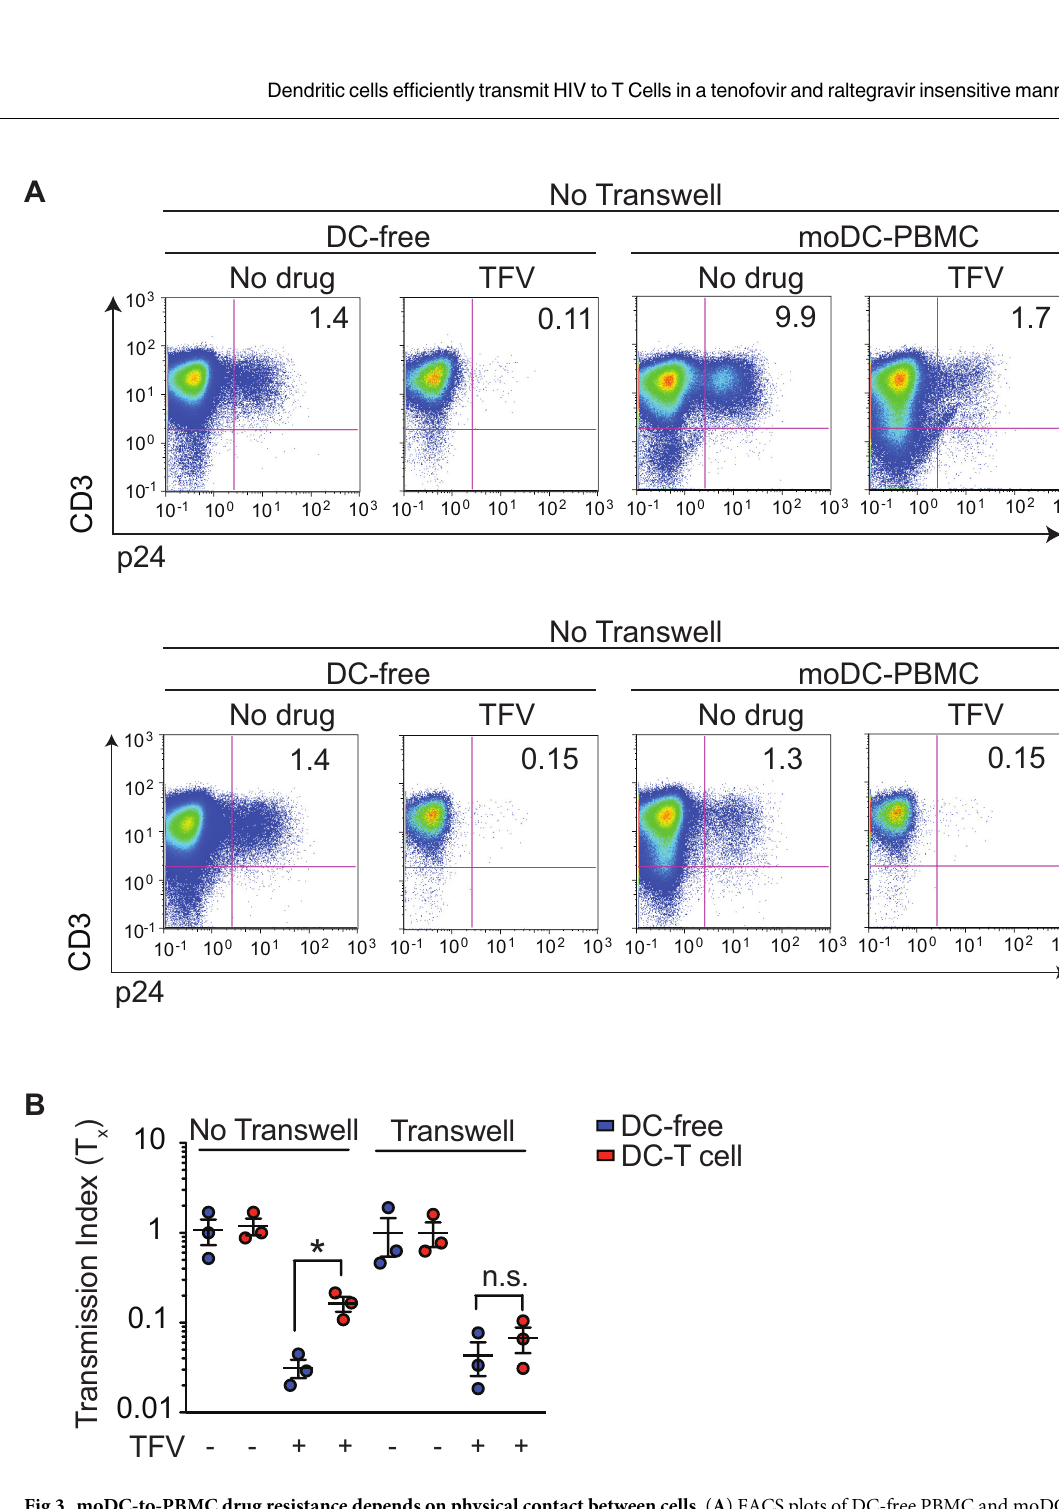
Fig 3. moDC-to-PBMC drug resistance depends on physical contact between cells. ( A ) FACS plots of DC-free PBMC and moDC- to-PBMC infection with ( bottom ) or without ( top ) a transwell system, in which DCs are physically separated from PBMCs by a transwell membrane. Infection occurs in the absence of presence of 10 μM of TFV. ( B ) Drug insensitivity (T x ) of DC-free or moDC- to-PBMC infection with or without 10 μM of TFV and in the absence of presence of a transwell system. Mean ± s.e.m ( η = 3 donors). (cid:3) , p < 0.05 (student’s T-test). n.s., p > 0.05. Each symbol represents a donor. Data is representative of two ( A , B ) independent